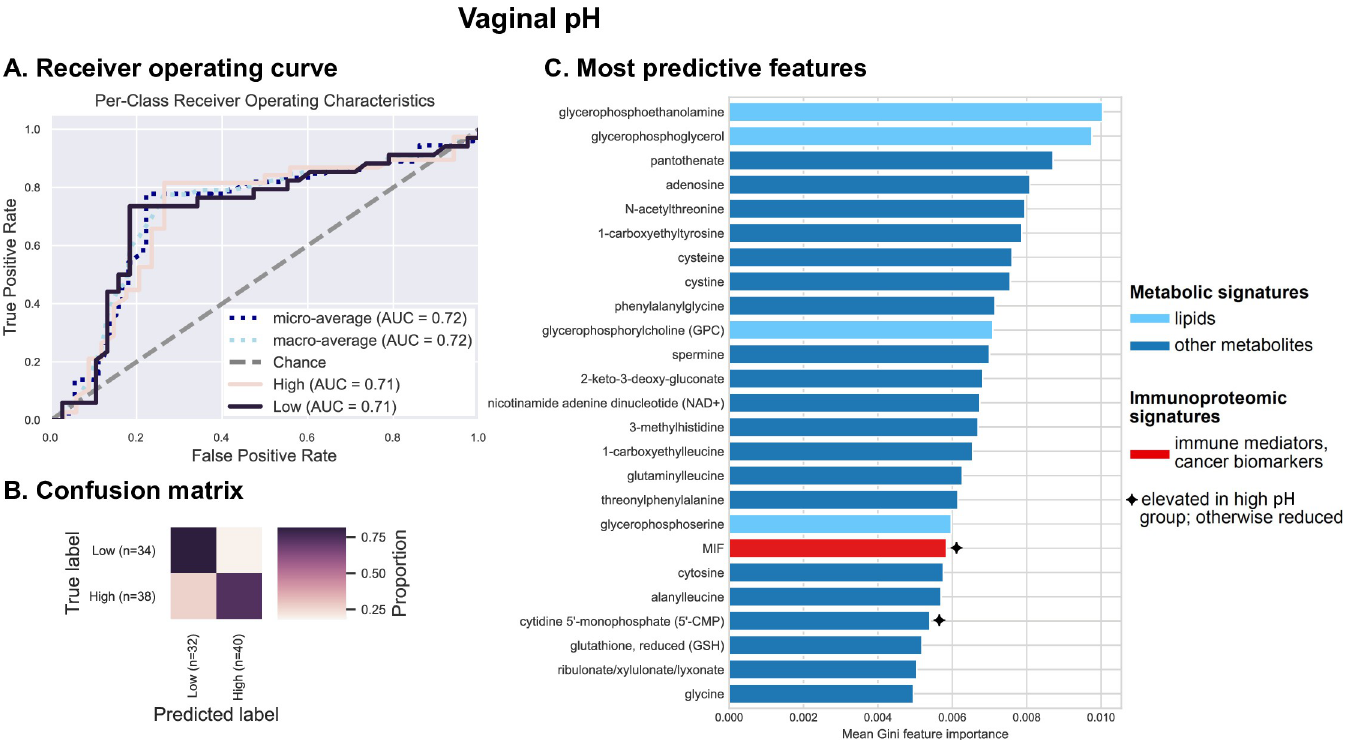
Fig 5. Metabolites (particularly amino acids, peptides and nucleotides) and inflammatory cytokine MIF are the best predictors of vaginal pH. Integrated vaginal microbiome, metabolome, and immunoproteome profiles were used as predictive features for training cross-validated Random Forest classifiers to predict whether a subject’s vaginal pH was low ( � 5.0) or high ( > 5.0). Combined measurements predict vaginal pH at an overall accuracy rate of 77.8%. A 1.5-fold improvement over baseline accuracy was observed. Receiver operating characteristics (ROC) analysis showing true and false positive rates for each group, indicating weak predictive accuracy (micro-average AUC = 0.72) for both low (AUC = 0.71) and high pH groups (AUC = 0.71) ( A ). The confusion matrix illustrates the proportion of times each sample receives the correct classification when evaluating the classifier at a threshold of 0.5 ( B ). The graphs depict the 25 most strongly predictive features ranked by their mean Gini importance score across all 10 trained classifiers, a measure of their overall contribution to classifier accuracy ( C ).